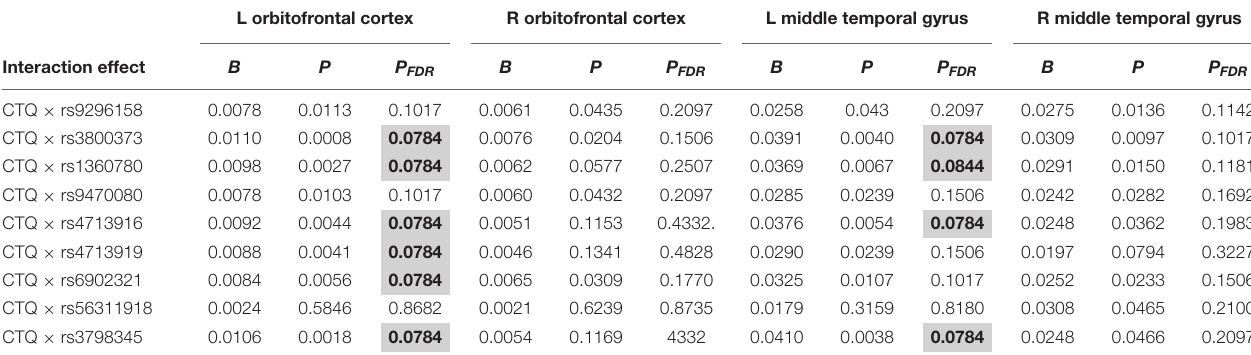
TABLE 2 | Statistically significant interaction effects of childhood trauma and FKBP5 variants on alteration of brain volumes ( N = 144). L orbitofrontal